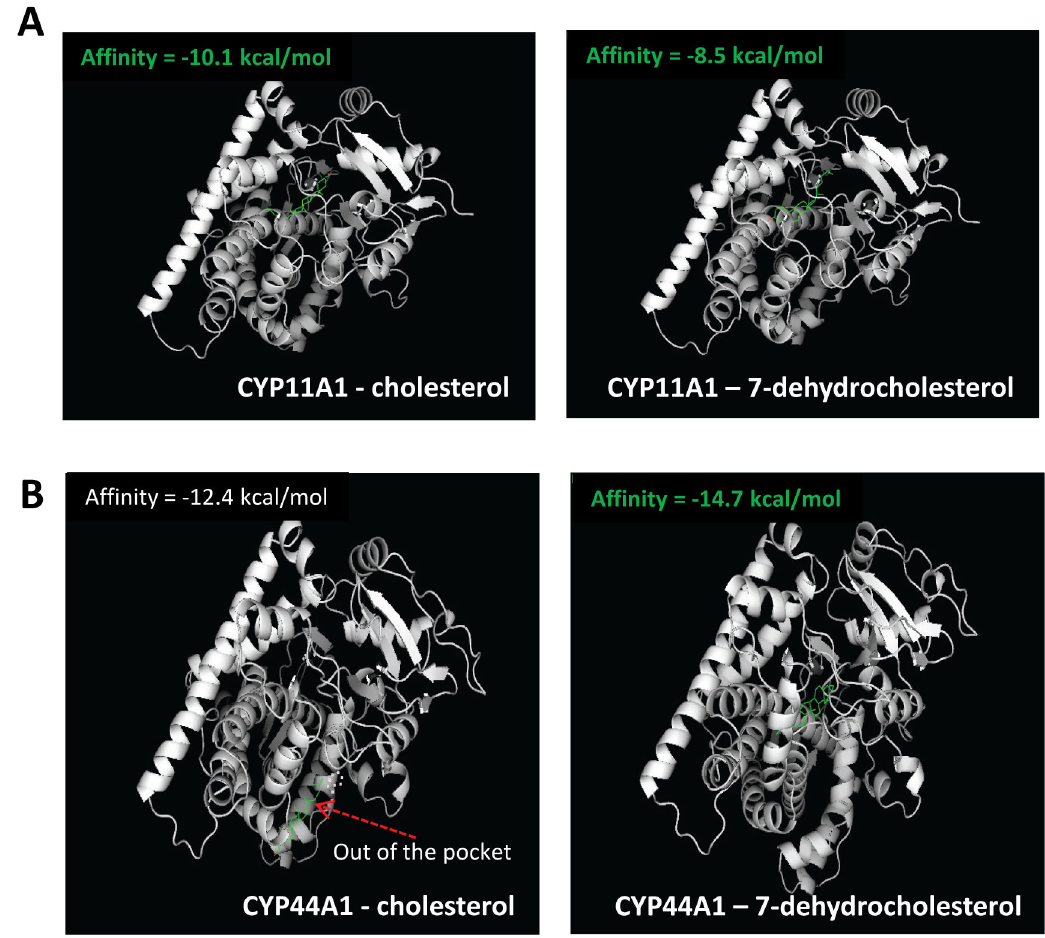
Figure 6. Comparative molecular docking analysis with the homology models of C. elegans CYP44A1 and the crystal structure of human CYP11A1 docking with cholesterol and 7-dehydrocholesterol. A. Docking of CYP11A1 with cholesterol (left) and 7-dehydrocholesterol (right). B. Docking of CYP44A1 with cholesterol (left) and 7-dehydrocholesterol (right). The docking results are shown as the top conformation in rank of free energy. Protein structures are shown in ribbon representation. Cholesterol is in a ball-and-stick model